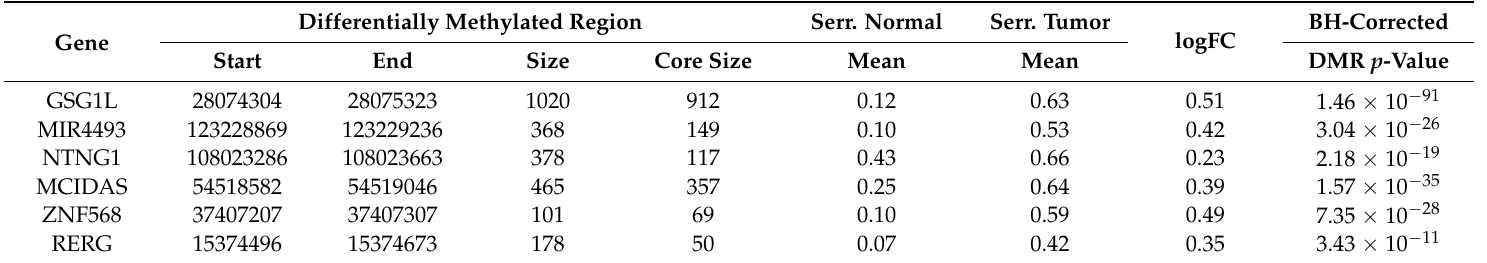
Table 3. Differentially Methylated Regions (DMRs) in Garcia-Solano et al. [15] serrated tumors vs.